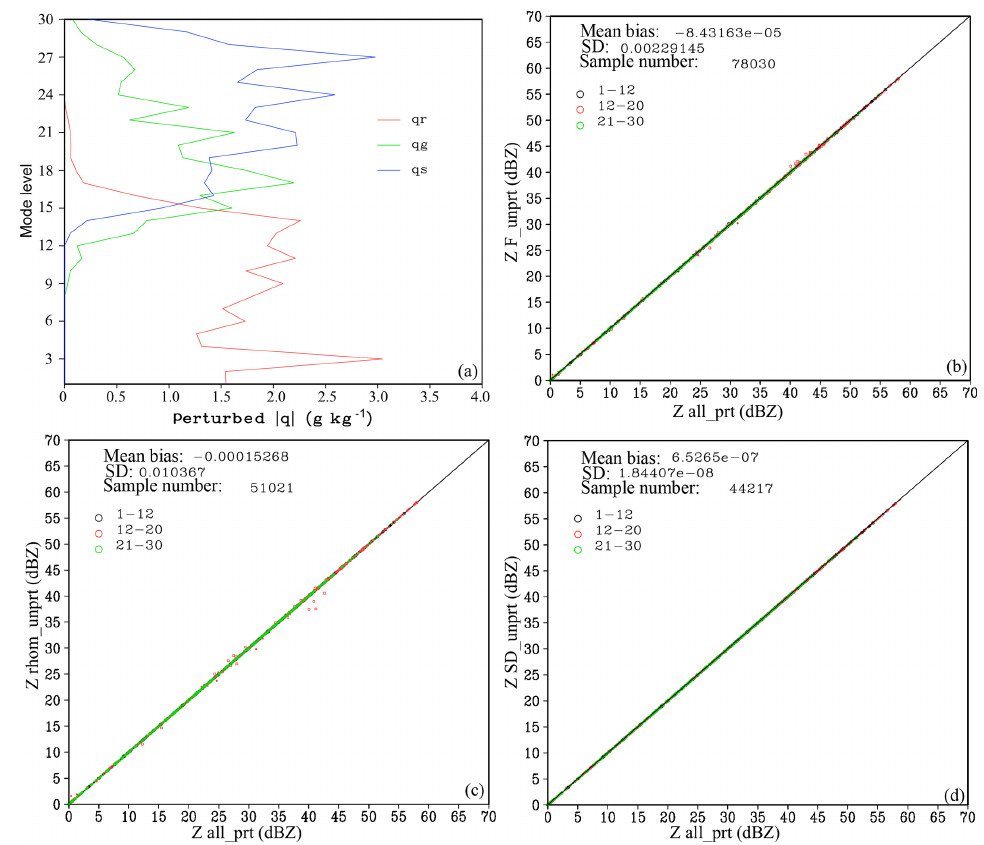
Figure 5. (a) Vertical distributions of the maximum absolute values of the perturbed q r (red), q s (green), and q g (blue). Reflectivity scatter plots of all_prt ( x axis) versus (b) F_unprt ( y axis), (c) rhom_unprt ( y axis), and (d) SD_unprt ( y axis) at model levels 1–12 (black, lower than 3kma.g.l.), 12–20 (red, between 3 and 7kma.g.l.), and 21–30 (green, above